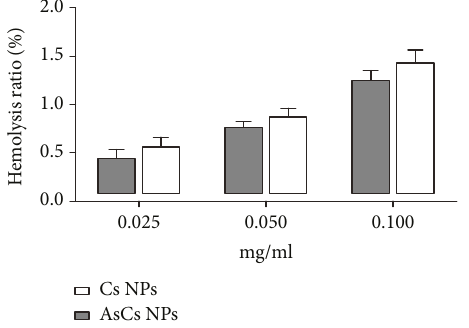
Figure 9: In vitro hemolysis assay of AsCs NPs. Hemolysis ratio of polymers at di ff erent concentrations.